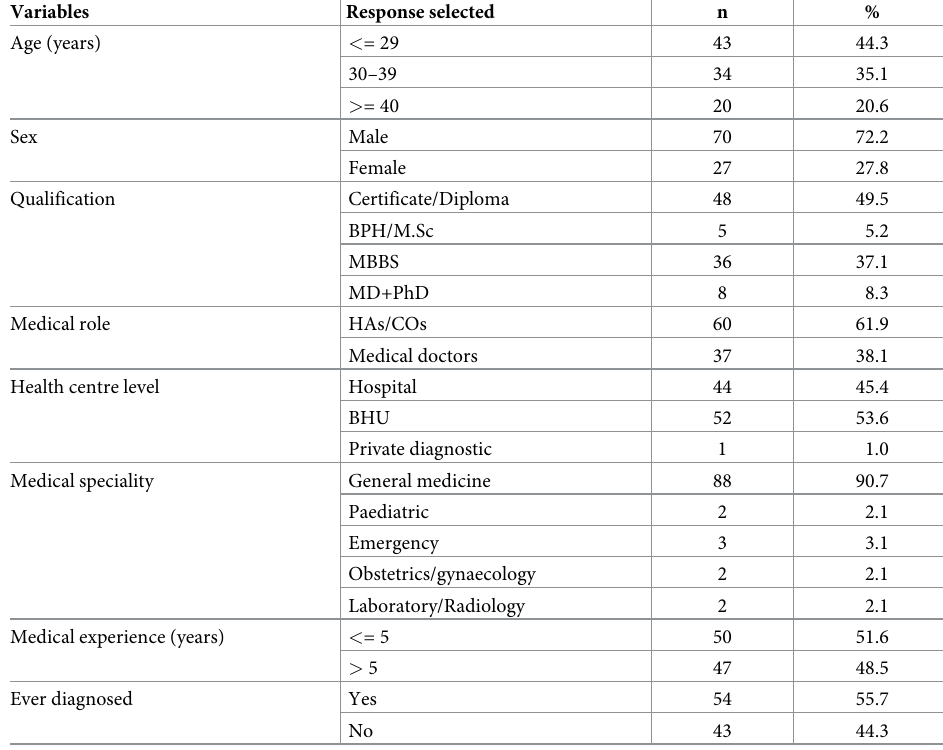
Table 1. Characteristics of the study